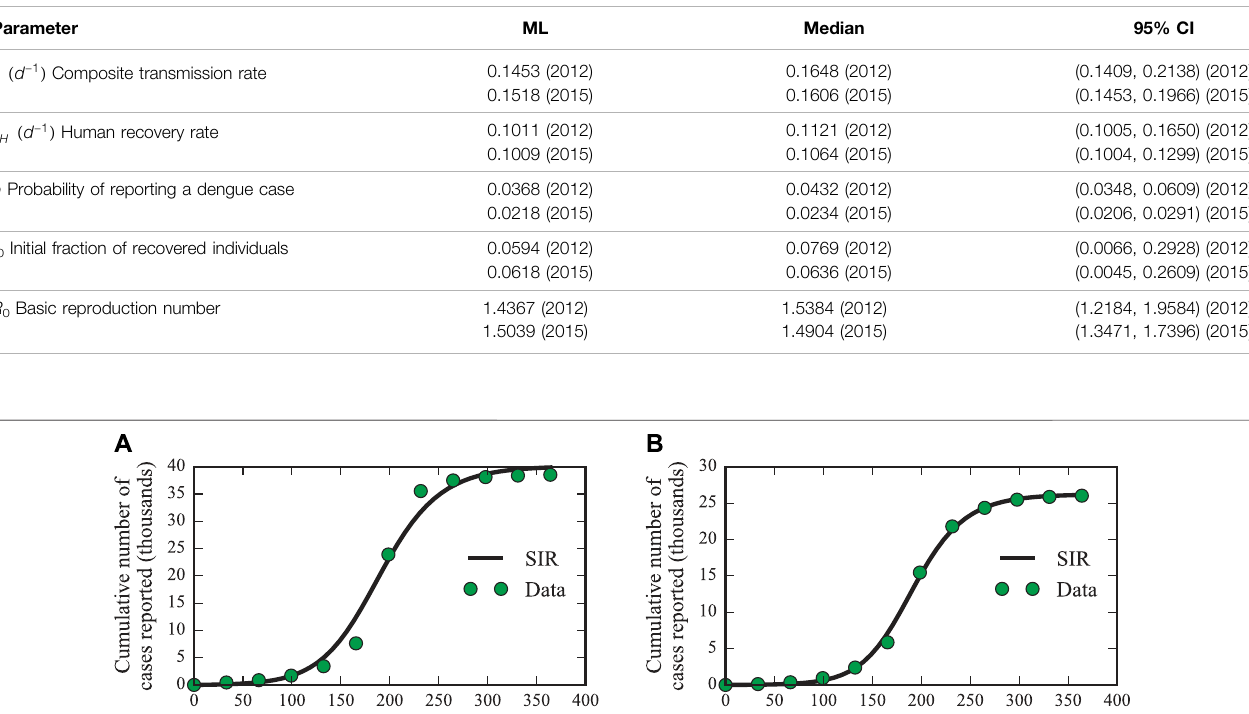
TABLE 3| Posteriorparameter estimations. Based onuniform prior SIRparameter distributions, thecorrespondingposterior distributions for thedengueoutbreaks in 2012 and 2015 have been obtained using Bayesian Markov chain Monte Carlo sampling. For both years an additional maximum likelihood (ML) parameter estimate is given. The posterior distributions are characterized by their median values and their 95% con fi dence intervals (CI).